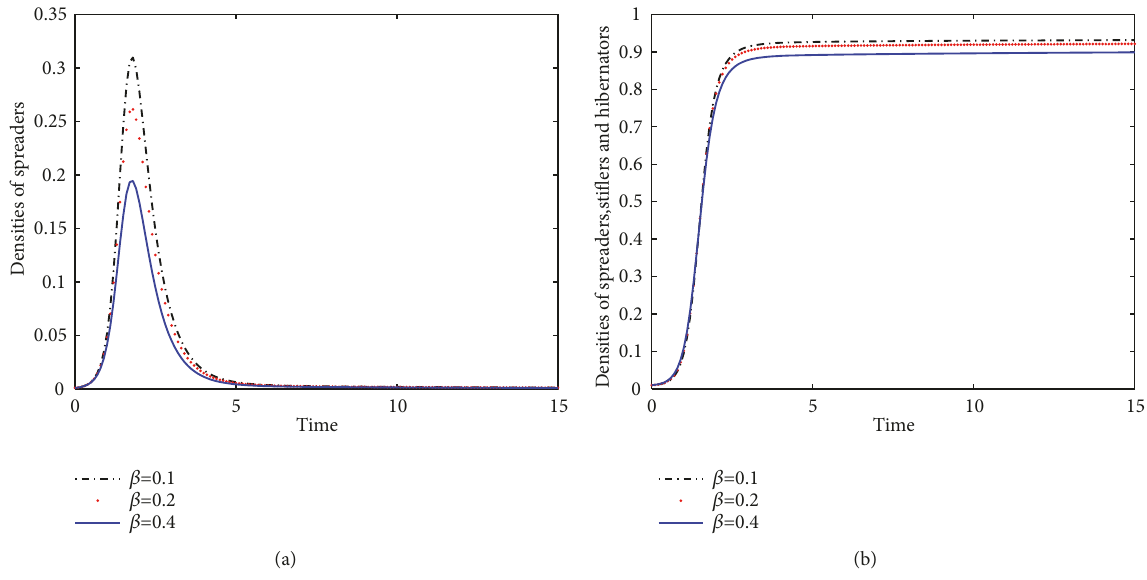
Figure 7: Numerical simulations of (3) with 𝜆 = 0.6 , 𝛼 = 0.2 , 𝛿 = 0.2 , 𝜉 = 0.1 , and 𝜂 = 0.2 and different refusing rates 𝛽 in the network with the Poisson degree distribution. (a) The trajectories of the densities of spreaders. (b) The trajectories of the densities of spreaders, stiflers, and hibernators.